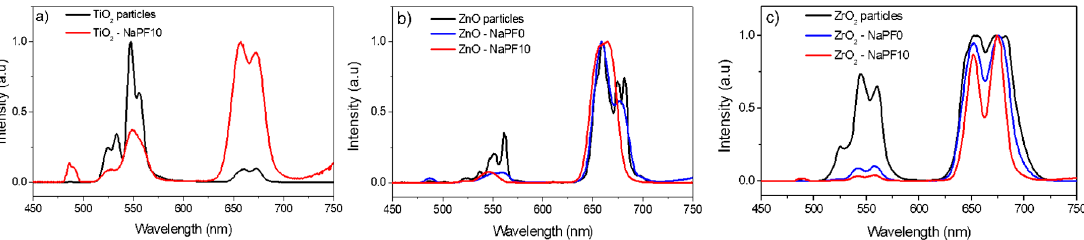
Figure 7. Normalized up-conversion emission spectra of the Er 2 O 3 -doped TiO 2 ( a ), ZnO ( b ), and ZrO 2 ( c ) particles and of the corresponding particles-containing NaPF0 and NaPF10 glasses with 1.25 wt % of particles.